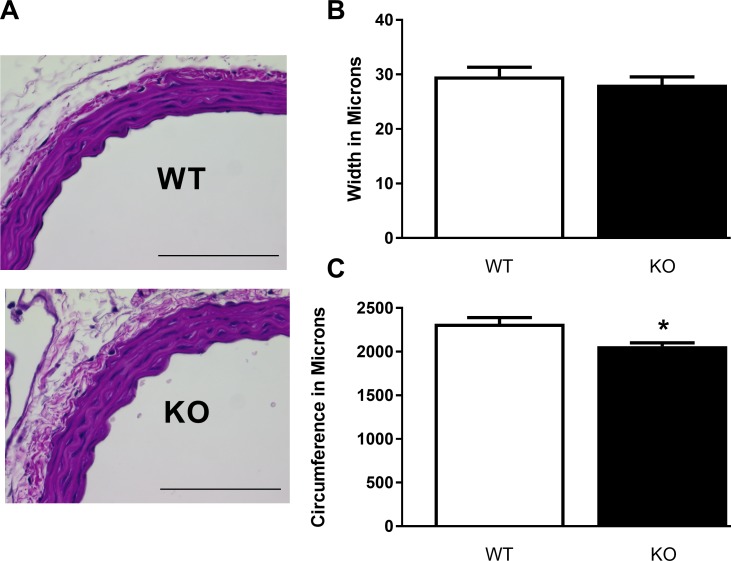
Histological appearance of thoracic aorta in wild-type (WT) and Slc29a1-null (KO) mice.Tissues were gravity perfusion fixed with paraformaldehyde, sectioned in the transverse plane and stained with haematoxylin and eosin. Layers of elastin as well as nuclei arrangement were analyzed (Panel A). Images are representative of six animals of each genotype. Scale bars represent 100 μm. Panel B shows the vascular wall thickness and lumen circumference derived from these tissue samples (Mean ± SEM, N = 6). * Significant difference in measured parameter between the wild-type and Slc29a1-null samples (Student’s t-test for unpaired samples, P<0.05).